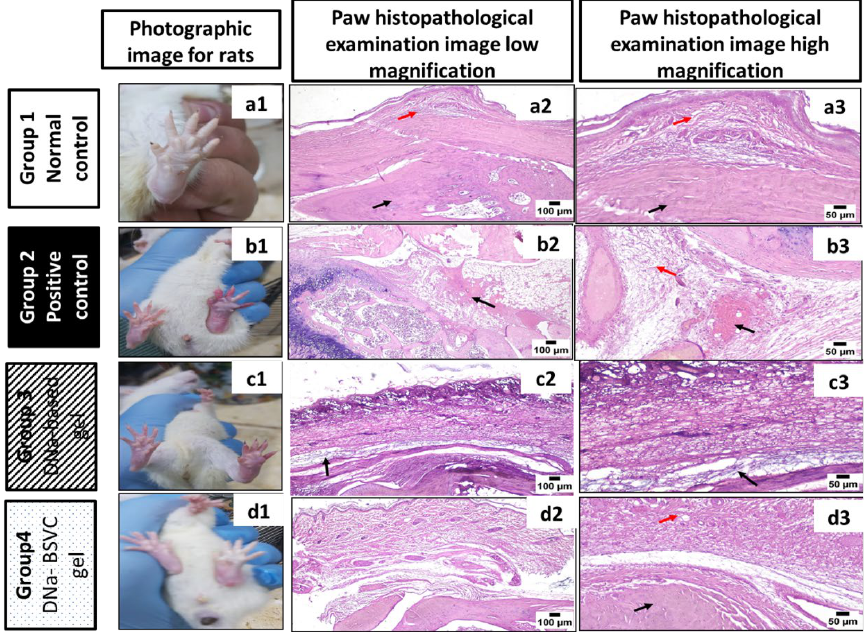
Figure 12. Photographic image for rats and photomicrographs of histopathological examination of paws (100 µm and 50 µm magnification) of each group. Where: ( a1 – a3 ), normal control group; ( b1 – b3 ), positive control group (induction with carrageenan); ( c1 – c3 ), DNa-based gel group (10 mg/kg); ( d1 – d3 ), DNa-BSVC gel group (10 mg/kg); (Figure a2,a3 ): photomicrograph of paw, control group (Figure b3 ): group showing marked edema (red arrow) and hemorrhage (black arrow) in the periarticular tissue, DNa-based gel; (Figure c2 , c3 ) showing moderate edema (black arrow) in the tissue surrounding the bone, and a DNa-BSVC gel group; (Figure d2 , d3 ) showing normal structure of bone (black arrow) and surrounding soft tissues (red arrow) (H&E). In agreement with our histopathological examination, Burayk et al. [91] revealed that rats subjected to carrageenan showed marked thickening of the dermal layer, inflammatory reaction in the deep dermis, and wide separation between fibers due to edema. In addition, a rheumatoid arthritis aggressive inflammatory model agrees with us that rats that received diclofinac presented a reduction in the number of inflammatory cells and hyperplasia of the synovium [92]. In addition, A transdermal formulation containing leflunomide and diclofenac-based gel showed significant relief of inflammation